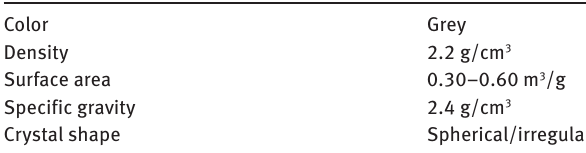
Table 1: Physical properties of WSD